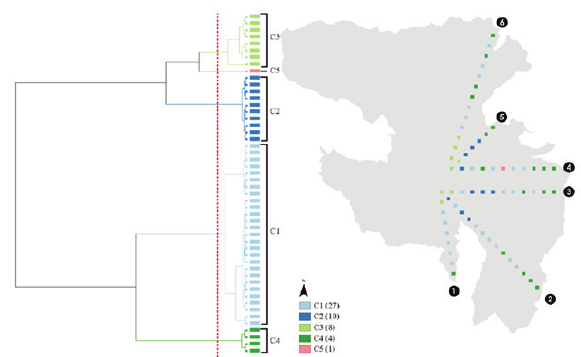
Figure 6. Cluster classifi cation that defi nes urban, periurban, rurban and rural samples in the MDQ (source: Ortiz-Báez et al.,